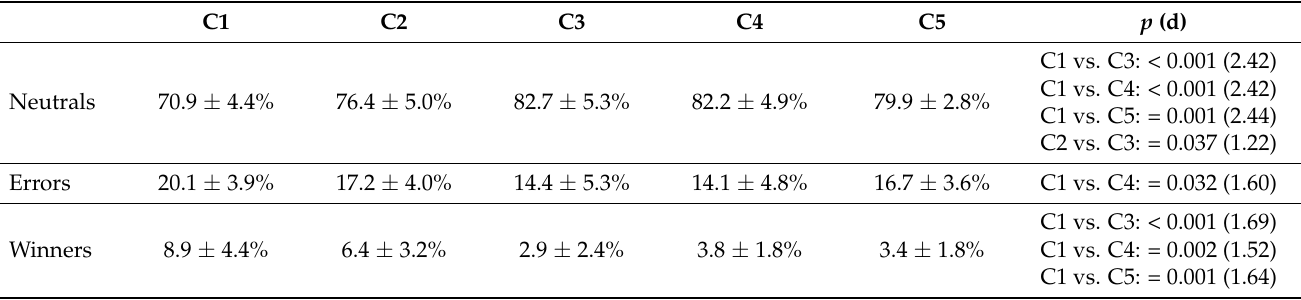
Table 8. Distribution of shots outcome for each class (mean ±